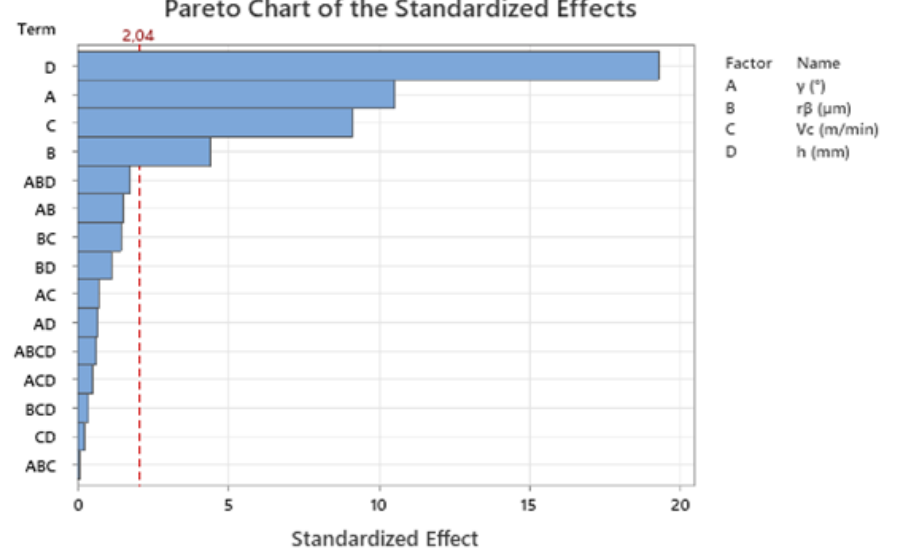
Figure 4. Pareto analysis of the factors affecting the cutting force ( F c ) based on all cutting condi- tions.